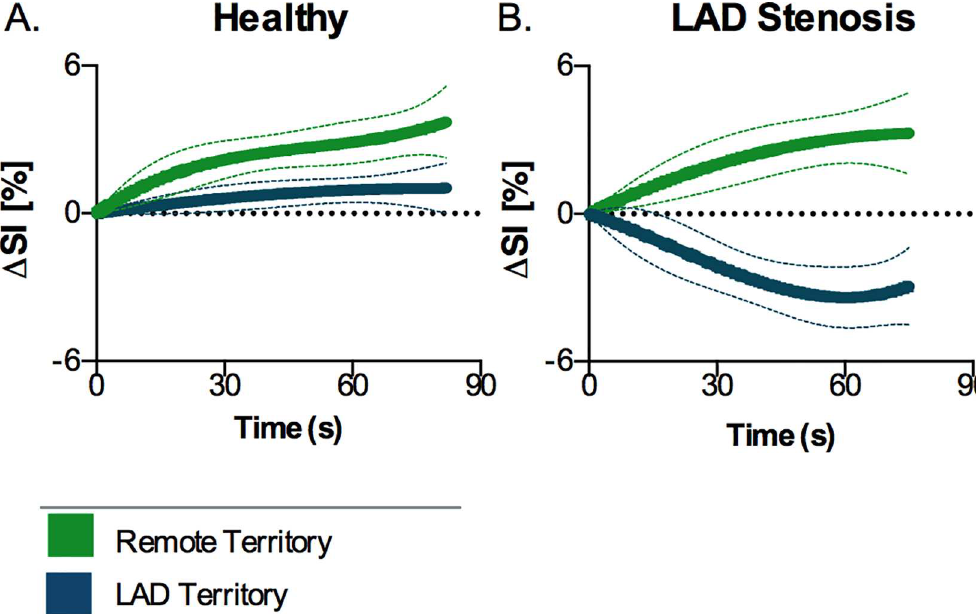
Fig 5. Myocardial oxygenation response curve during the HVBH. Signal intensity increasesglobally during the HVBH in control animals (A), yet the animals with a stenosis (B) show a significant decrease in the LAD territory (blue), while the remote region (green) remains above baselinewith a similar characteristic of the control animals.